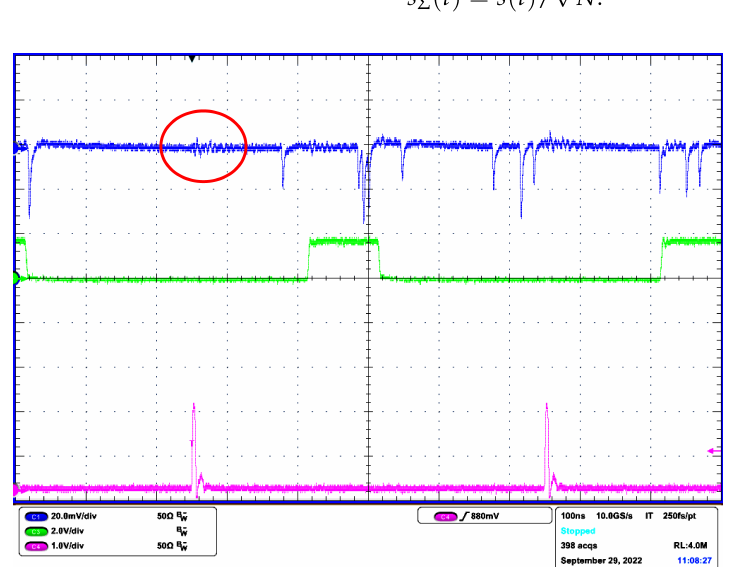
Figure 12. Raw signals captured by oscilloscope (Channel 1—SiPM output v p 2 ; Channel 3—FPGA pulse to VCSEL, Channel 4—sync pulses). The red circle shows electrical crosstalk from sync pulses.